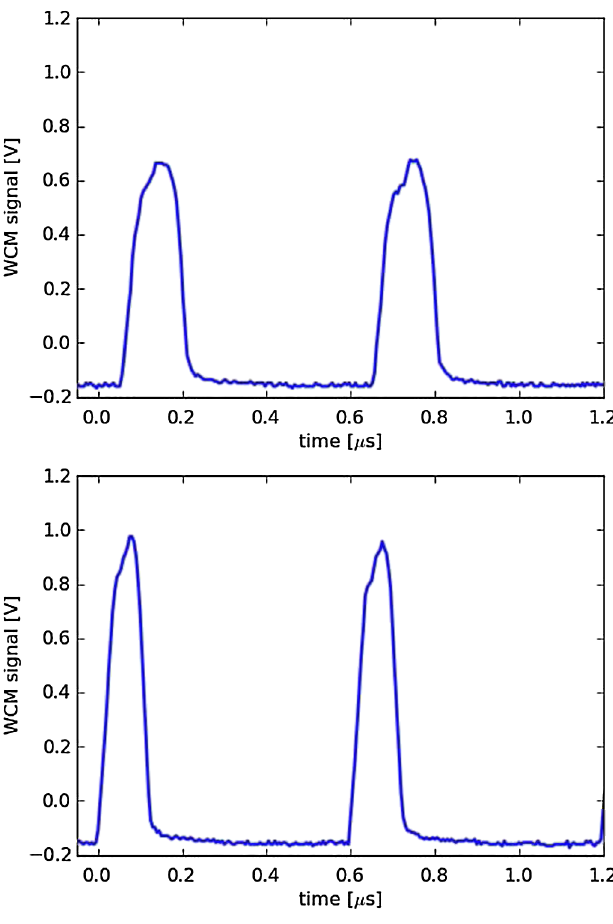
FIG. 22. Bunch shapes of just before extraction (top) without and (bottom) with the feedforward.